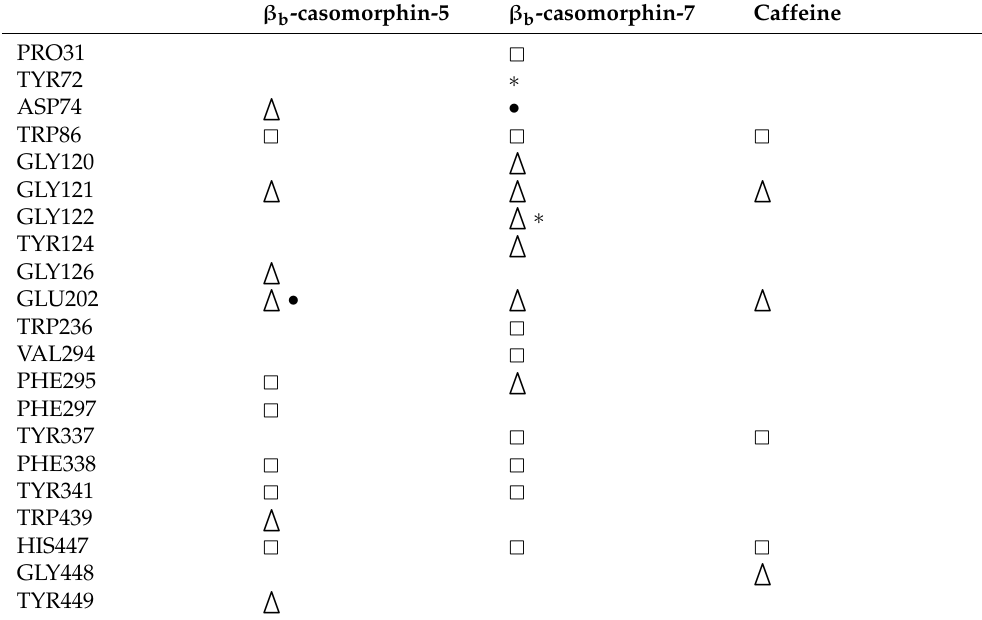
Table 4. AChE (PDB: 2 × 8B) interact with compounds ( bonds; • : electrostatic bonds; ∗ : unfavorable bonds). β b